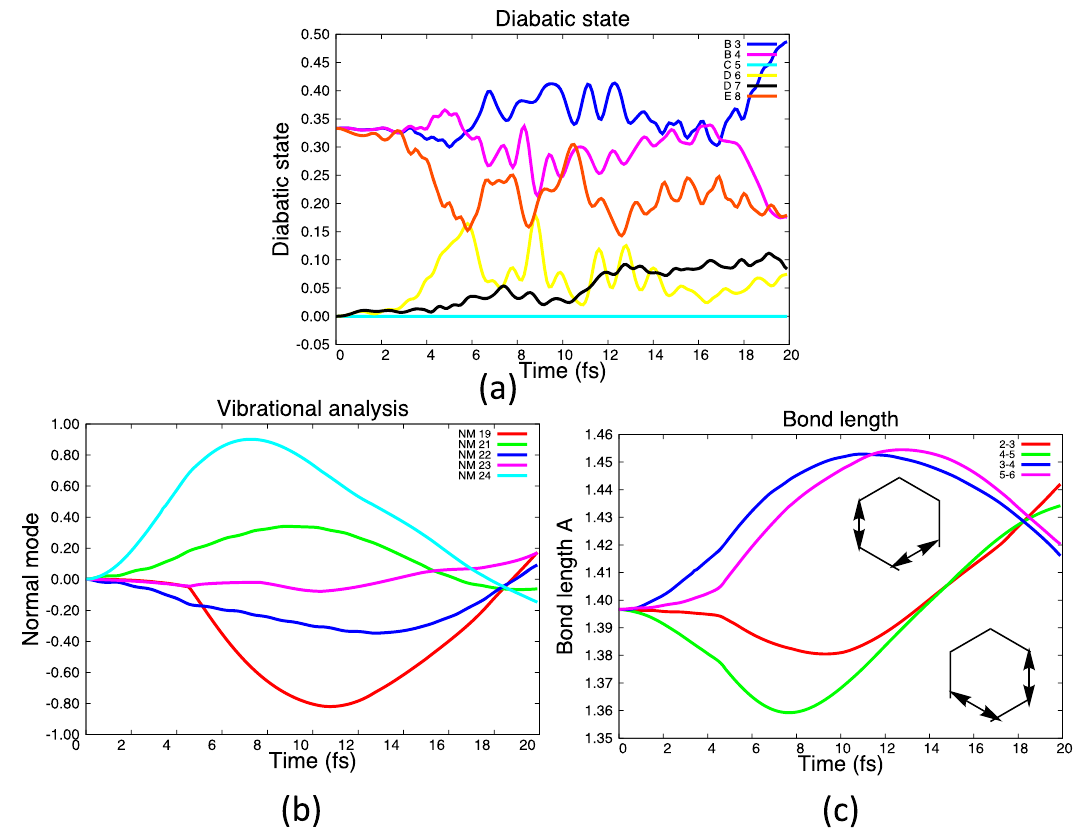
Fig. 7 Results of E + B, 3-state initial superposition with Qu – Eh dynamics. The labels E 8 , D (D 7 D 6 ), etc. refer to the singly ionized states in Fig. 2. The atom labels 1 – 6 in the carbon atoms start at the top of the hexagon. a Populations of diabatic states. b Normal mode displacements. c Bond vibrations for dominant stretches. (Note that the apparent sudden onset of nm 19 is just an illusion from the plotting software. Examination of the raw data shows that it is